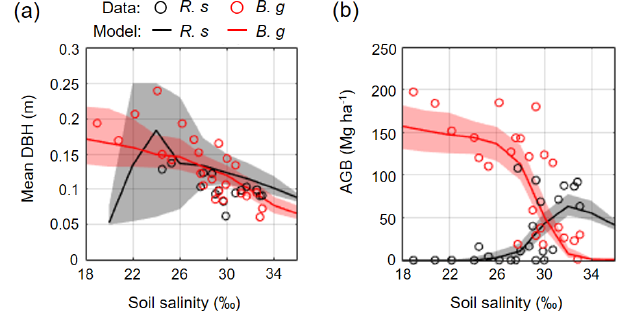
Figure 8. Comparison of field-measured and modeled (a) mean DBH and (b) AGB of R. stylosa and B. gymnorrhiza along with soil salinity gradient. From each ensemble simulation, modeled mean DBH and AGB in steady states ( > 300 years) were extracted and pooled for all ensembles, and the median (solid line) and the 90th percentile (shading) of the pooled samples are shown. Note that trees with DBH < 0.05m were not included in the calculation of the mean DBH.